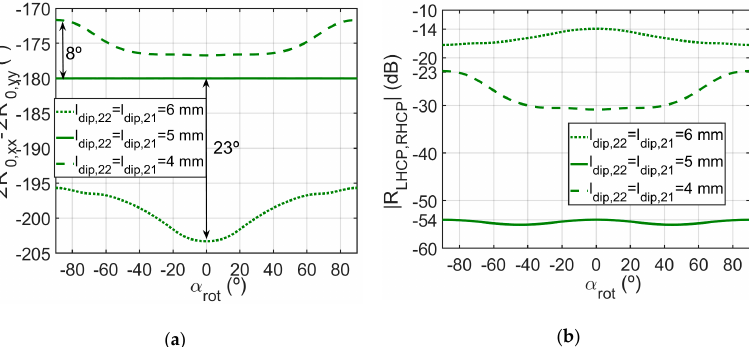
Figure 3. ( a ) Simulated difference between the phases of R’ 0 ,xx and R’ 0 ,yy provided by the pairs ( ψ arc , α rot ) shown in Figure 2a for different values of l dip , 21 = l dip , 22 . ( b ) Simulated magnitude of the cross-polar coefficient R LHCP,RHCP (provided by the pairs ( ψ arc , α rot ) shown in Figure 2a) as a function of the rotation angle α rot . The numerical results are shown at 12 GHz under incidence angles θ i = 19 °, ϕ i = 0°. If we use the element of Figure 1a,b for the design of a circularly polarized antenna by ESVT at 20 GHz, the lengths of the dipoles l dip, 21 and l dip, 22 have to be adjusted to preserve the condition R 0 ,xx = − R 0 ,yy , which is necessary to keep the sense of circular polarization after reflection on the reflectarray antenna. Figure 4a shows a color-map of the subtraction ∠(cid:1844) (cid:2868),(cid:3051)(cid:3051) − ∠(cid:1844) (cid:2868),(cid:3052)(cid:3052) as a function of the dipole lengths l dip, 21 and l dip, 22 . These results have been obtained for fixed values of ψ arc as α rot (we have chosen ψ arc = 118.9° and α rot = 0° in accordance with Figure 2a). Black solid lines in Figure 4a indicate the locus